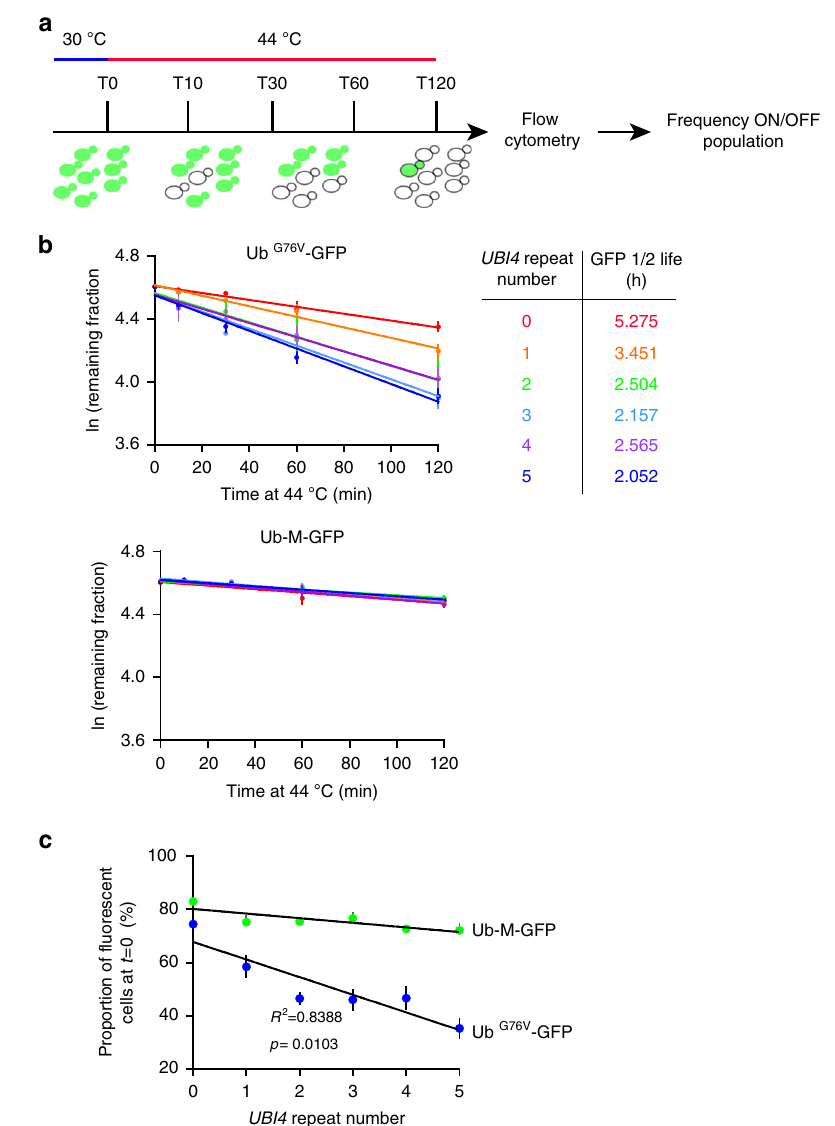
Fig. 4 Quantitative protein turnover measurements during heat shock reveal UBI4 repeat number-dependent degradation kinetics. a Experimental design for turnover measurements using fl uorescent protein reporters. UBI4 repeat variants expressing Ub G76V -GFP (a substrate for UPS-mediated proteolysis) or Ub-M- GFP (stable GFP) 27,28 were used to measure the UPS activity during heat shock (44°C). Cells were grown at 30°C until exponential phase in SC medium with 2% galactose to induce the expression of the fl uorescent reporters. The cultures were then shifted to 44°C and samples were taken before the temperature shift (T0) and at multiple time points after for fl ow cytometry analysis. For each time point, the fraction of fl uorescent cells over the total cell population was calculated. b We then fi t the fraction to a fi rst-order decay function to calculate the degradation rate constant K deg . Since growth is completely arrested during the heat shock period, we do not expect any contribution from protein dilution rates (as a result of cell division). Protein half-lives were calculated using the formula T (1/2) = ln (2)/ K deg . c The initial proportion (i.e., before heat shock) of fl uorescent cells over the total population gives the steady-state levels of the reporter proteins and re fl ects the UPS activity under physiological conditions. b , c Data are mean of 4 independent replicates ±